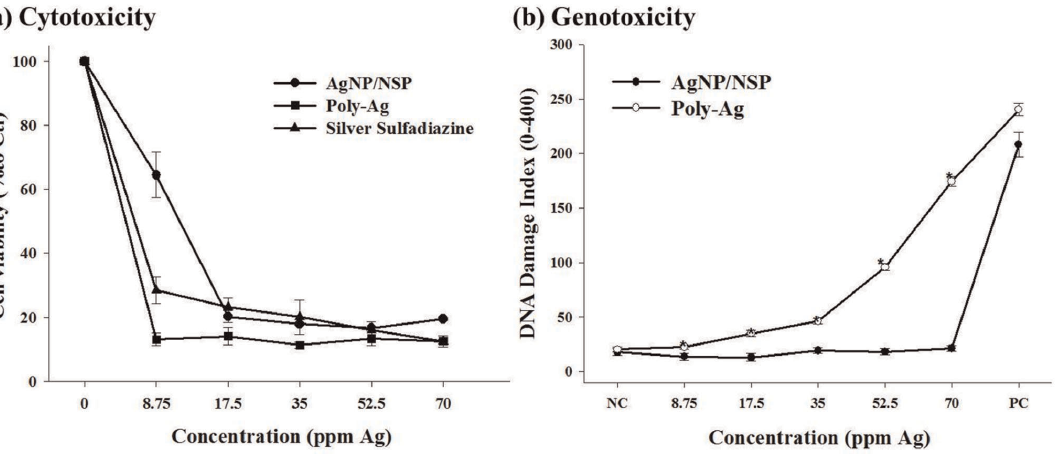
Figure 1. Cytotoxicity toward the human foreskin fibroblast (Hs68) cell line after 12 h of incubation with AgNP/NSP, polymer dispersed AgNP (Poly-Ag) and silver sulfadiazine (SS) using the MTT assay (a). The values are expressed as the mean 6 SD from 4 independent experiments. DNA damage in Chinese hamster ovary (CHO) cells by the comet assay showed the average lengths of the cell tails after incubation with different concentrations of AgNP/NSP and Poly-Ag (b). Data are shown as the mean 6 SD (at least 200 cell tails were counted in each sample). * P , 0.05 at each concentration, Student’s t test.